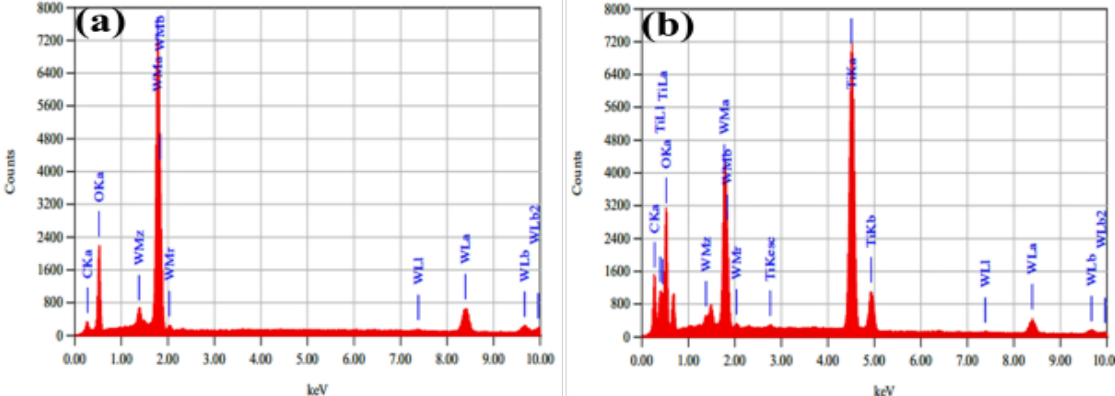
Figure 5. EDX analysis of ( a ) WO 3 and ( b ) WO 3 /MXene nanocomposite.